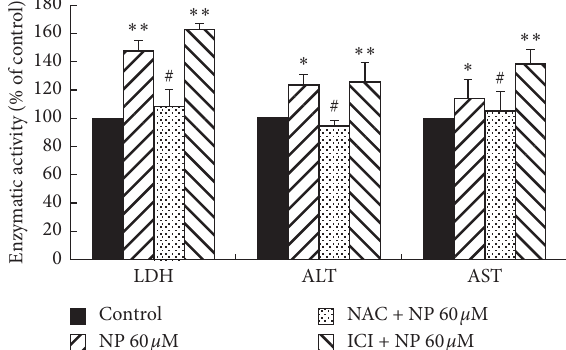
Figure 8: Effects of NAC and ICI 182,780 on NP-induced alter- ation of LDH, ALT, and AST activities. Results are presented as mean ± SD with triplicate measurement. ∗ P < 0 . 05, ∗∗ P < 0 . 01 versus the control group, # P < 0 . 05 versus 60 μ M NP